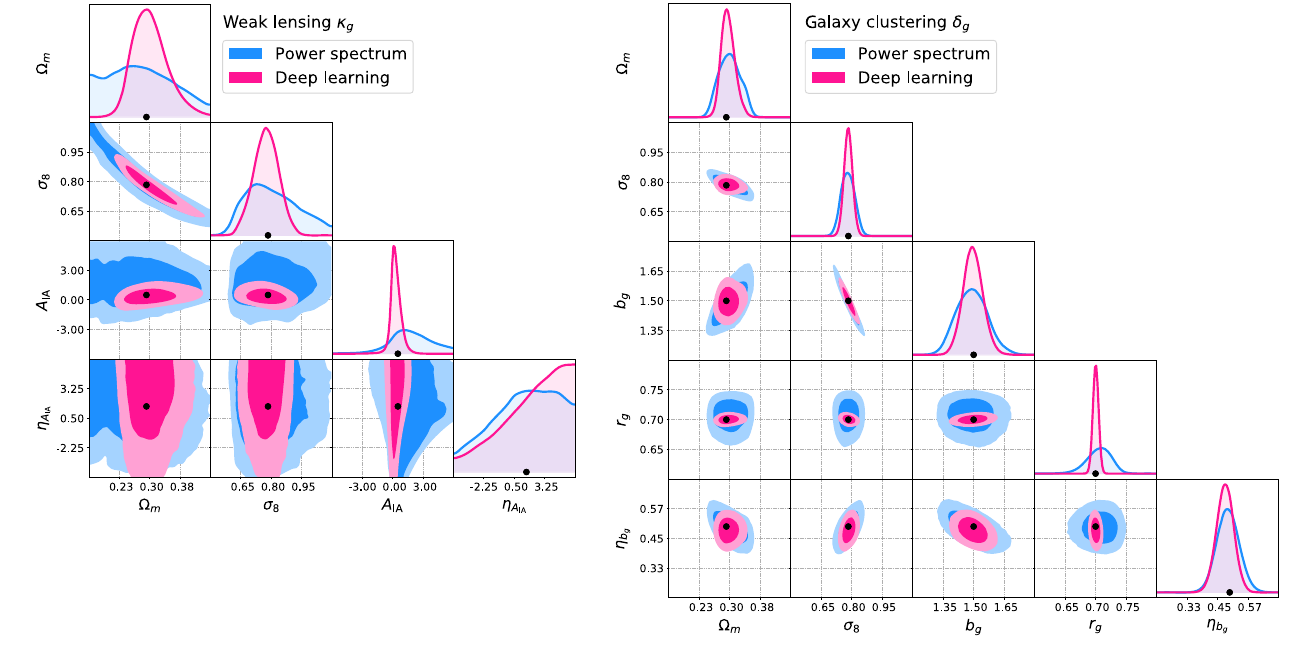
FIG. 3. Constraints for weak lensing (left) and galaxy clustering (right), with deep learning (pink) and power spectra (blue), for the main model with linear galaxy bias. As in Fig. 2, the black dots show the true parameters.